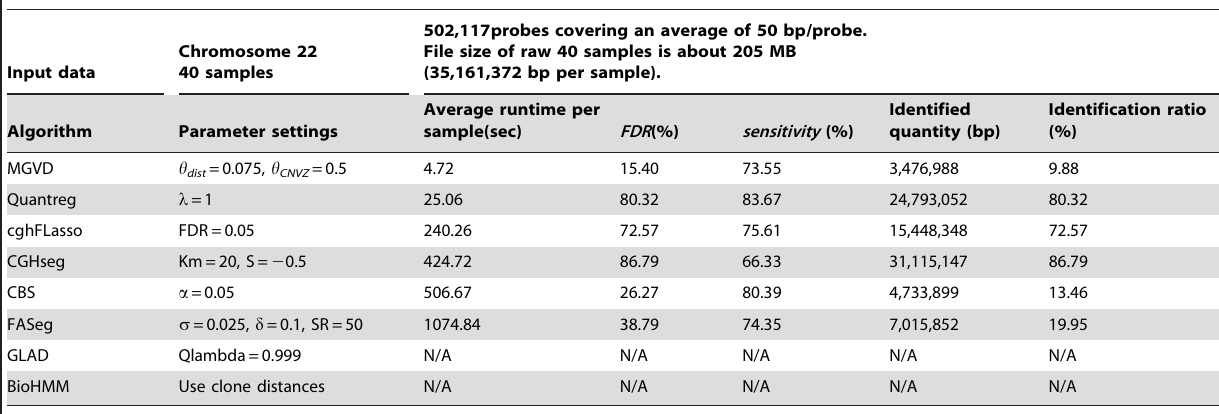
Table 1. Comparison of the performance of MGVD with those of other algorithms.